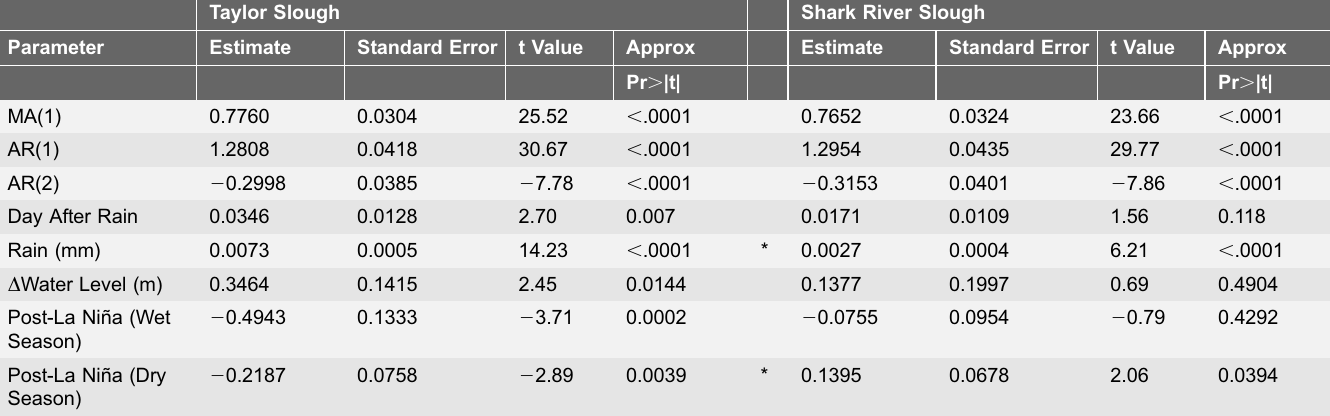
Table 4. Parameter estimates from ARIMA models of daily NEE by site.